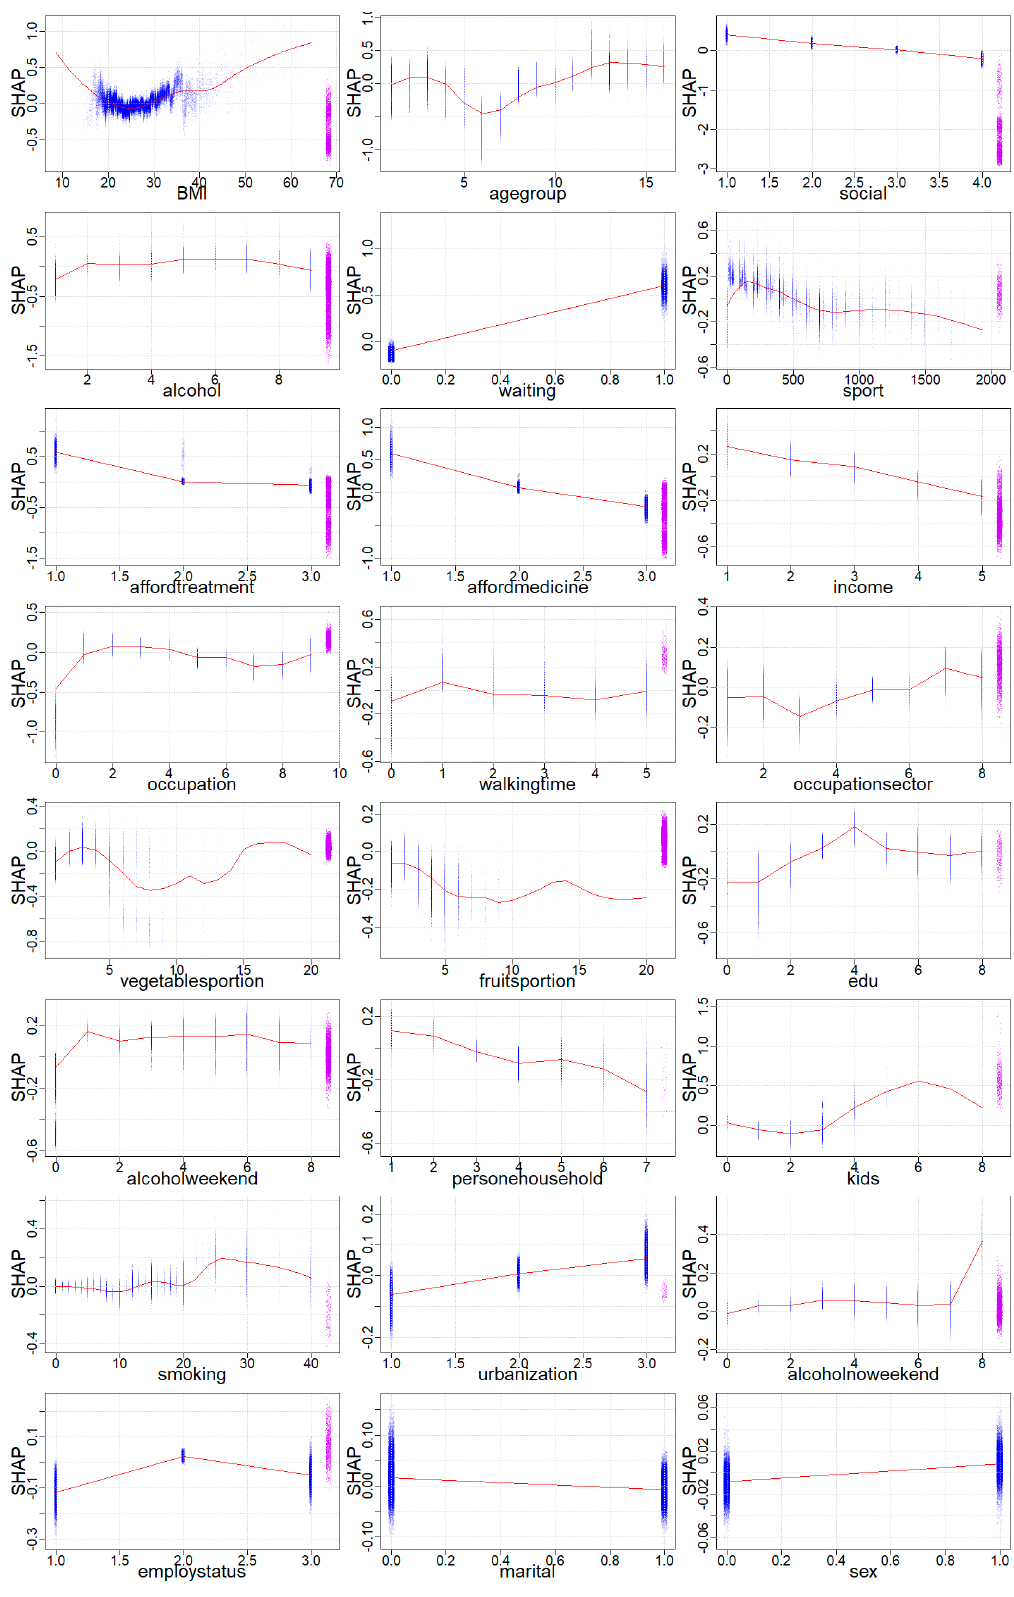
Figure 3. Mental health SHAP value dependency analysis for the EU+ total population. The order of variables is based on feature importance ranking from Figure 2. Source: Authors’ elaboration based on microdata from EHIS 2015 [64].